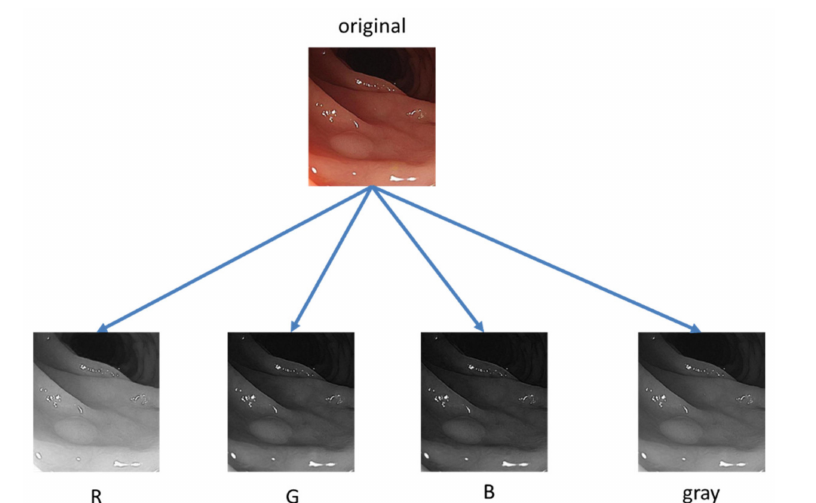
Figure 4. Conversions from a RGB image to four R, G, B, and grayscale